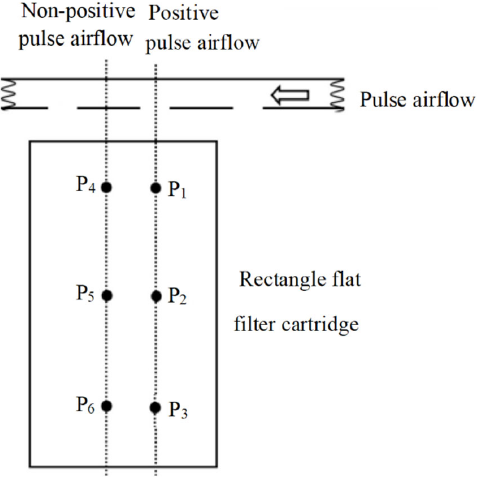
Figure 1. Schematic diagram of the flat filter cartridge positive and non ‐ positive pulse airflow.